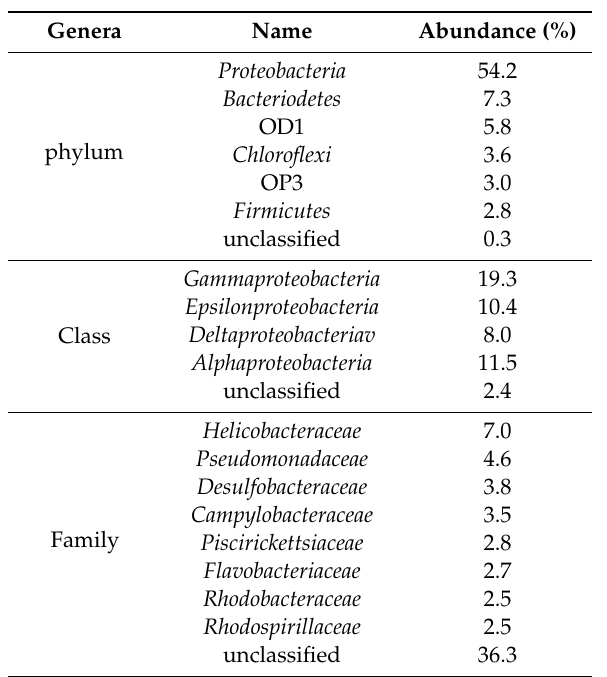
Table 2. Taxa identification and abundances above 2.0% abundance at the Phylum, Class and Family level.